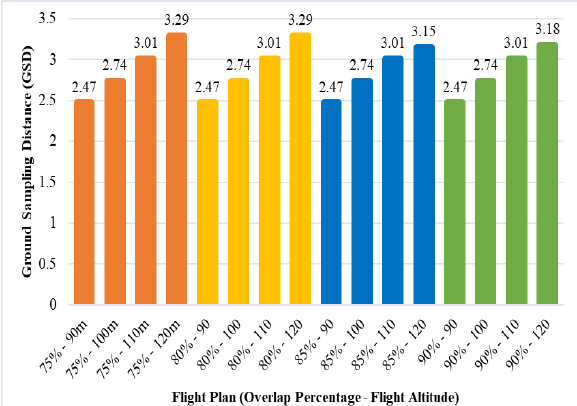
Figure 5 . Bar Graph for the visualization of flight plans based on GSD with respect to overlap percentage and flight altitude.